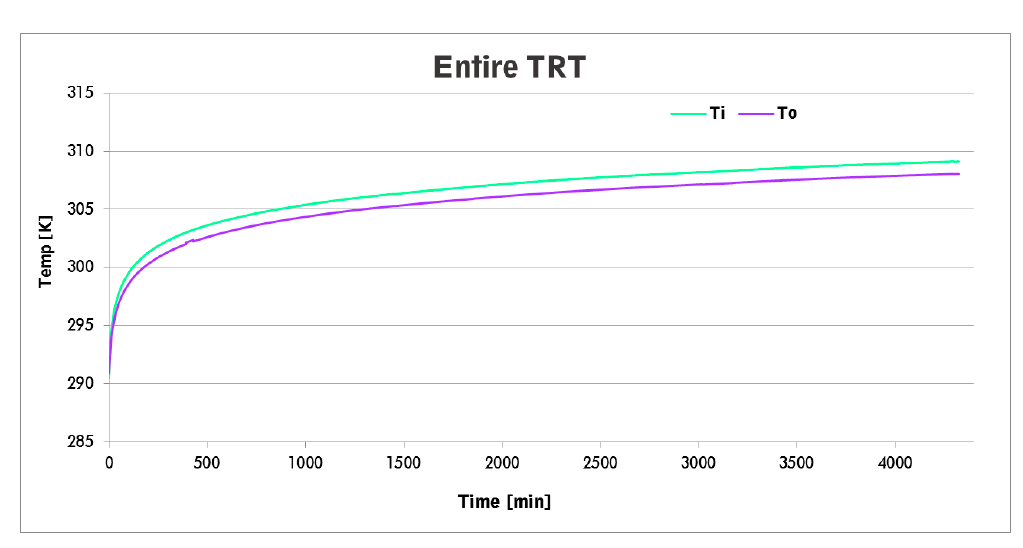
Figure 3. Inlet and outlet fluid temperatures (entire TRT, 72 h).